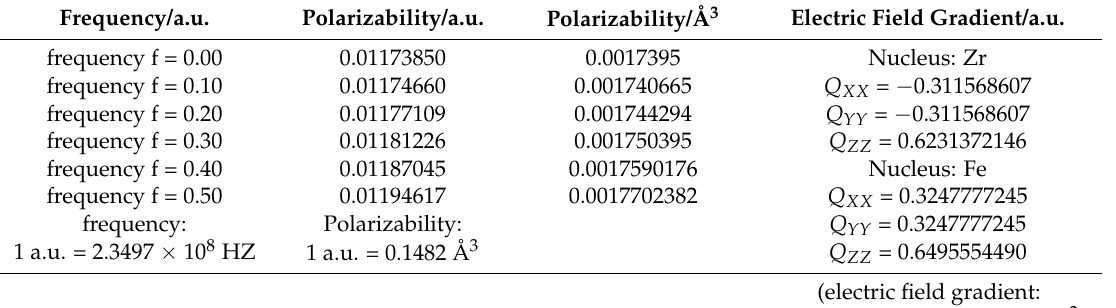
Table 2. Polarizability and electric field gradient of molecular Zr 2